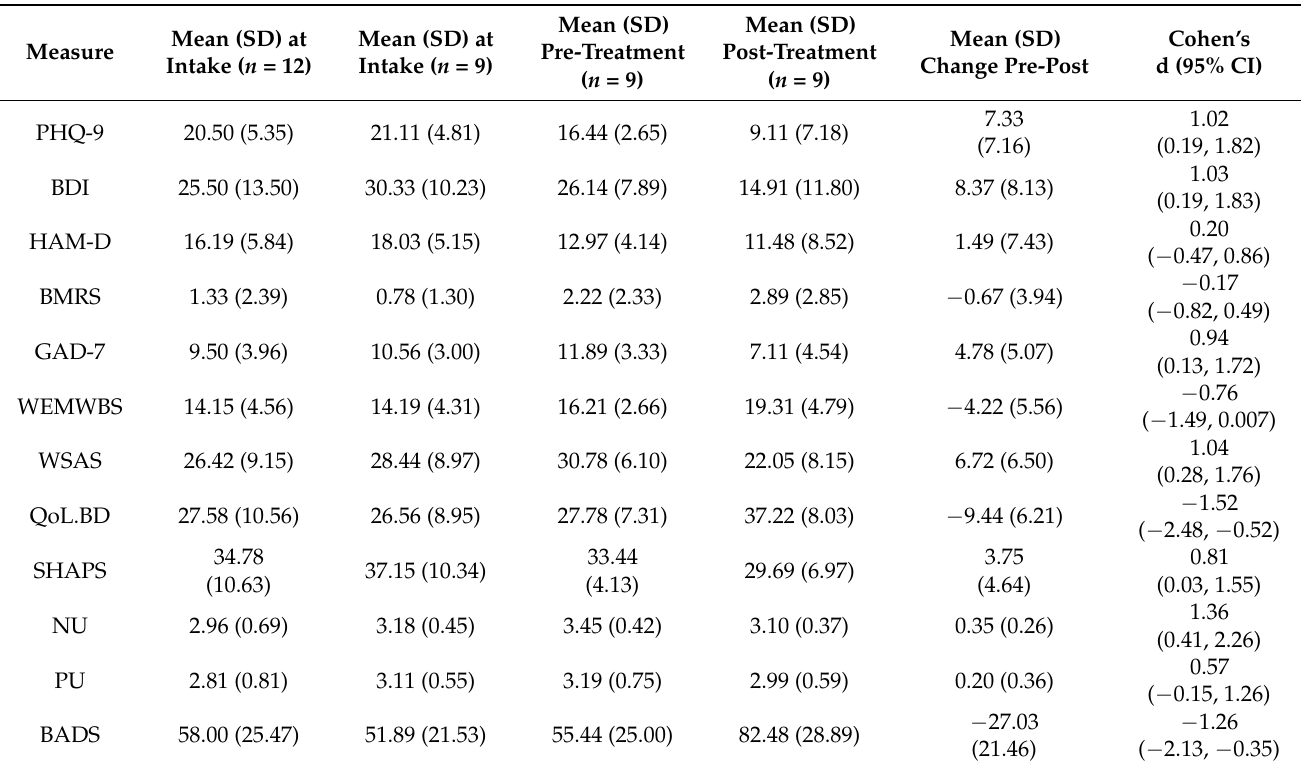
Table 3. Mean (SD) and proportion showing reliable and clinically significant change for outcome measures over the study